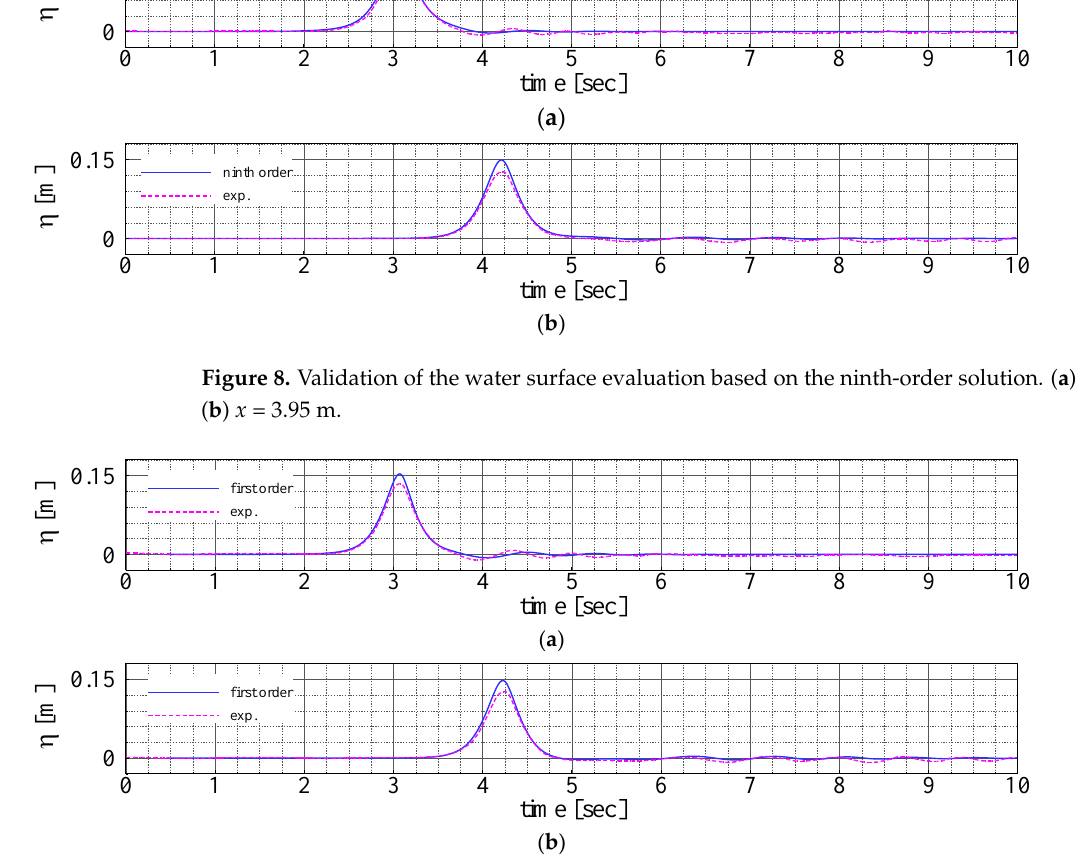
Figure 9. Validation of the water surface evaluation based on the first-order solution. ( a ) x = 1.55 m; ( b ) x = 3.95 m.